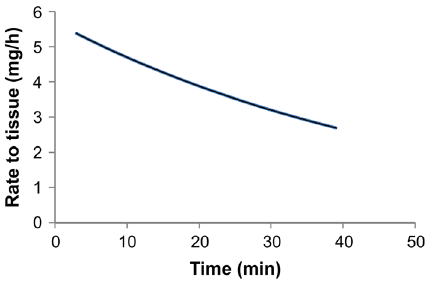
Figure 6. Rate of nicotine transfer from saliva to the tissue over 40 min of a smokeless tobacco use based on the dissolution dosimetry model (Eq.